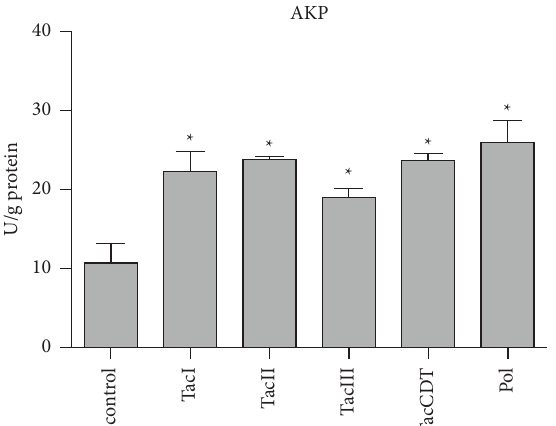
Figure 3: Te activity of AKP in control LM bacterial suspensions and LM bacterial suspensions containing the fve sLAMPs. ∗ p < 0 . 05.